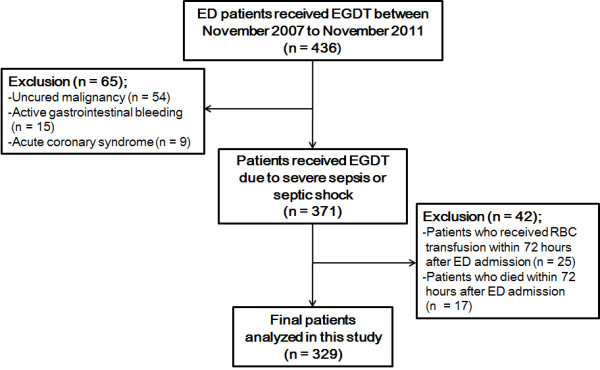
Flow diagram of study subjects. From November 2001 to November 2011, 436 patients who received early-goal directed therapy (EGDT) in the emergency department (ED) were assessed for possible enrollment according to inclusion and exclusion criteria, and 329 patients were included in the final analysis.